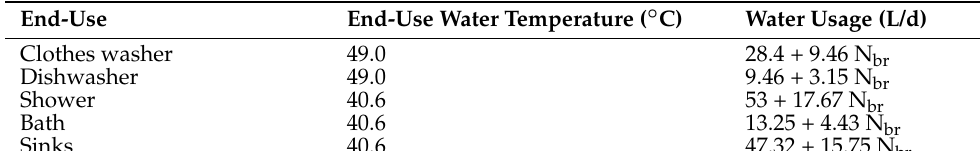
Table 3. Domestic hot water consumption by end-use.